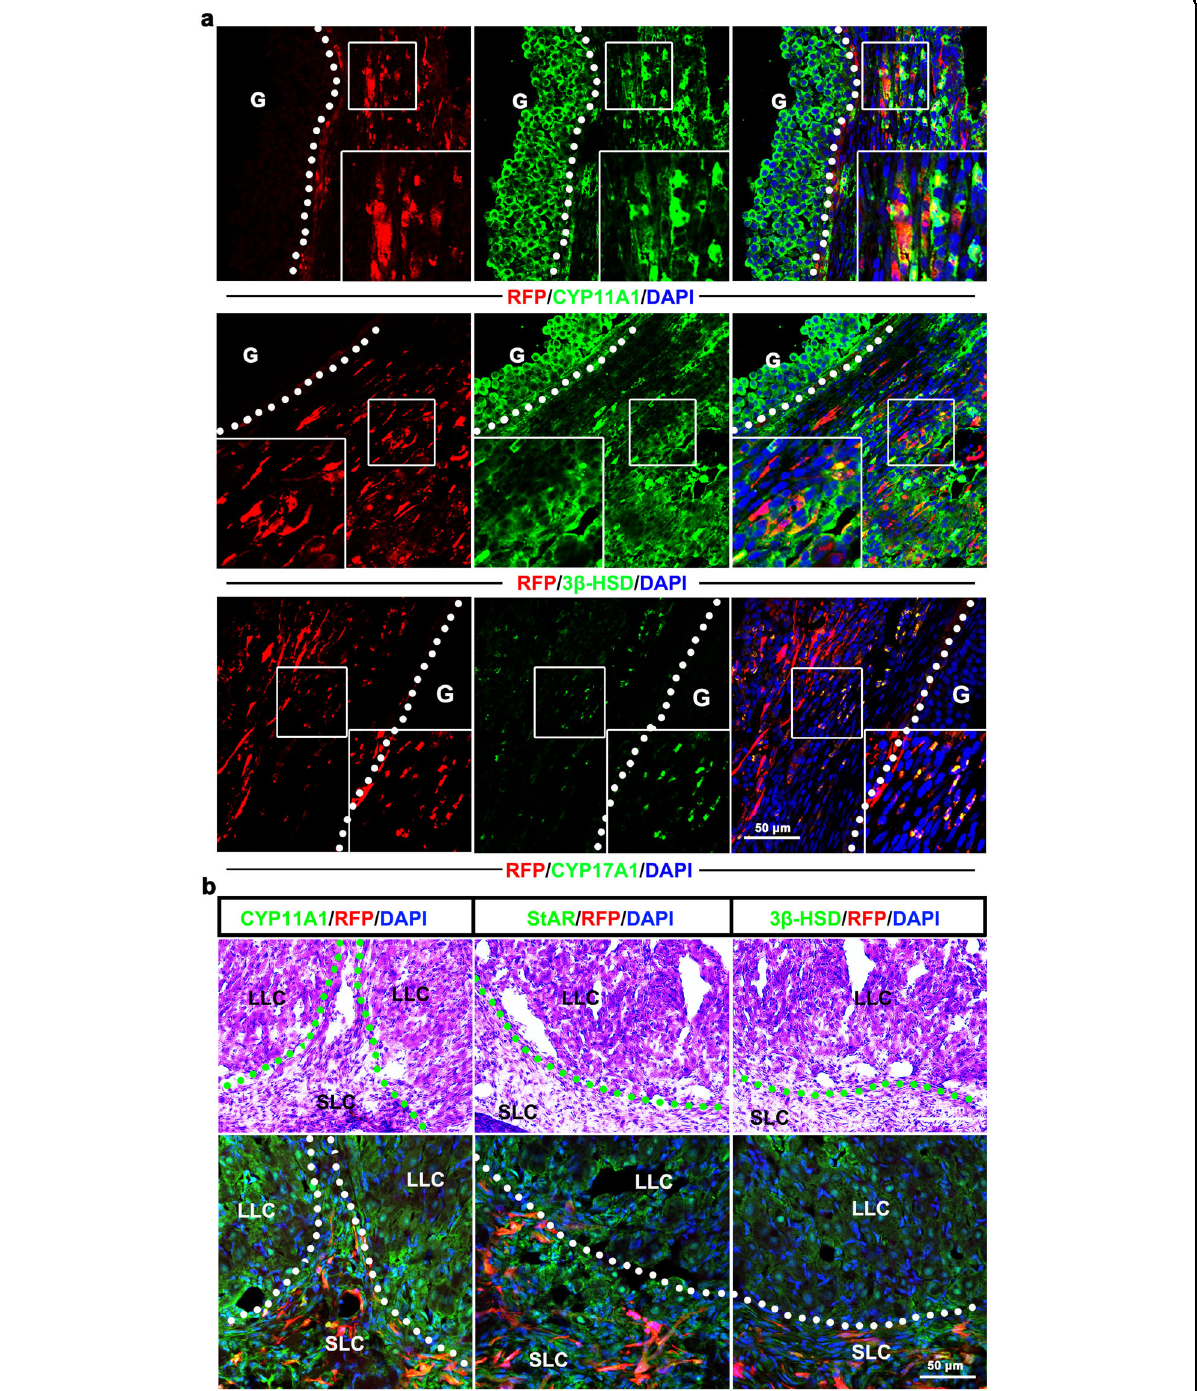
Fig. 5 Transplanted TSCs regenerate theca cells in the follicles of monkeys with POI. a CYP11A1, 3 β -HSD, and CYP17A1 coexpressed with RFP- positive cells in the theca membrane of the ovarian follicle, G granulose cells. The staining for CYP11A1 and 3 β -HSD was observed not only in the theca cell layer but also in granulosa cells in large antral follicles. b CYP11A1, StAR, and 3 β -HSD co-expressed with RFP-positive cells in the corpus luteum, LLC large lutein cells, SLC small lutein